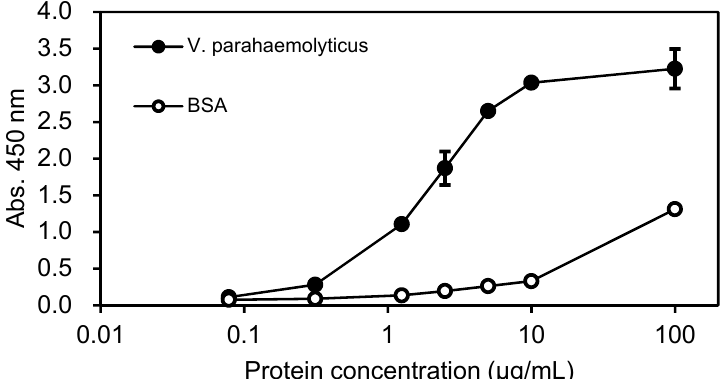
Figure 3. ELISA results of the refolded and purified Zipbody 22 G clone for V. parahaemolyticus. Error bars indicate standard deviations.